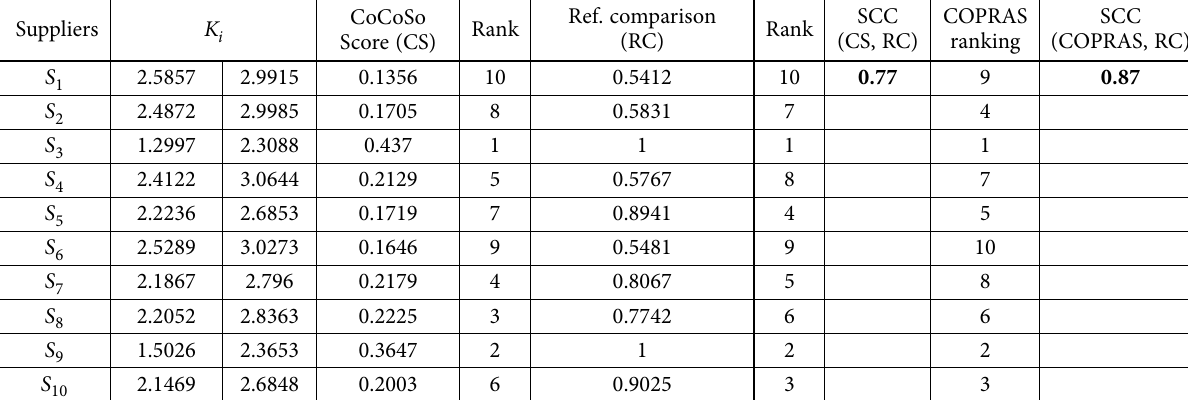
Table 15. The final ranking of suppliers for